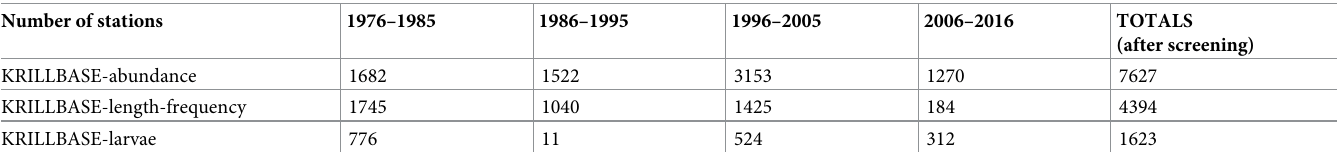
Table 2. The number of stations, per approximate 10-year period, provided by each of the data sets after screening. The lower numbers of stations in the decade 2006–2016 reflects an increase in the use of acoustics and a decrease in funding for large scale surveys. S2 Table provides further breakdown of stations into early and late austral season coverage for every sampling